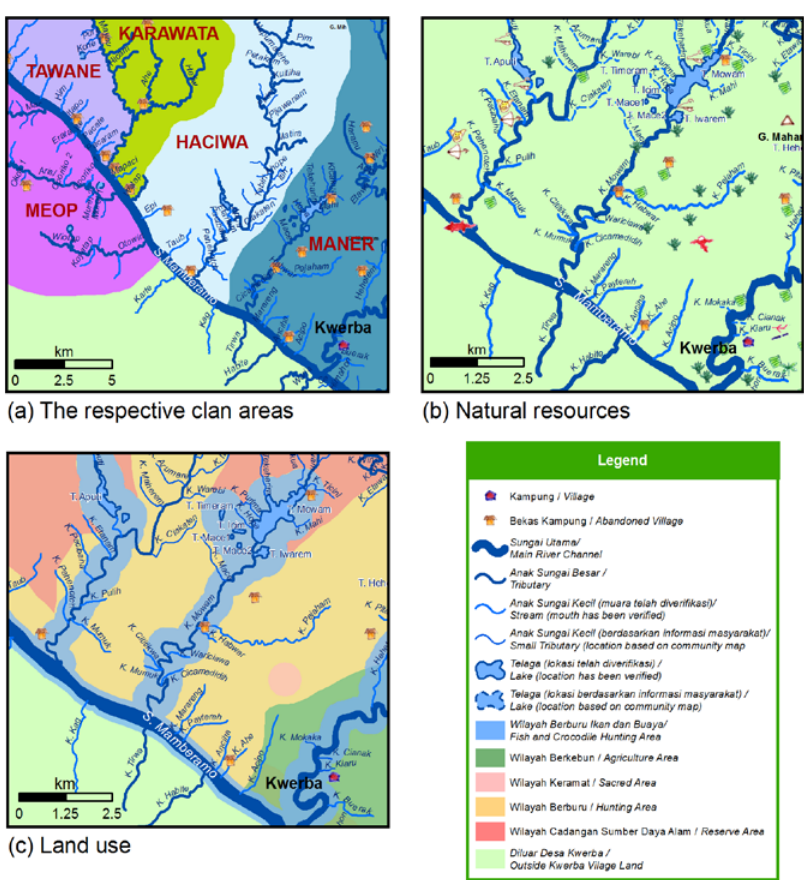
Figure 2. Sections of the participatory map and a common legend. ( a ) The respective clan areas; ( b ) Natural resources; ( c ) Land